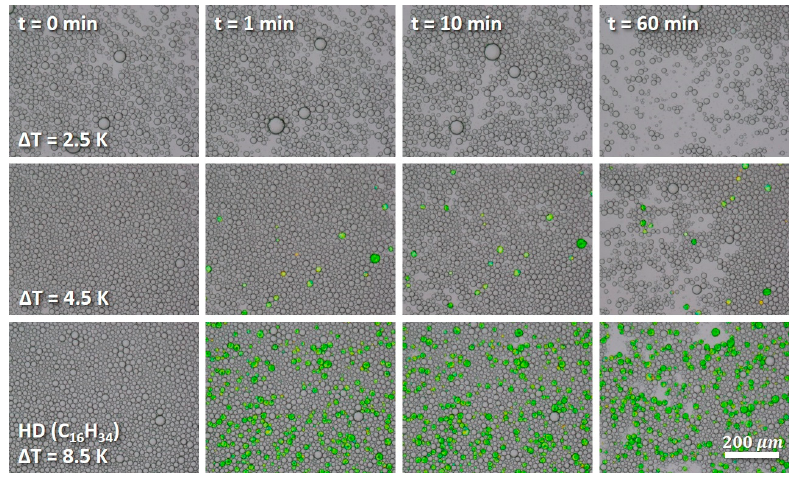
Figure A4. Micrographs of 1 wt % HD dispersions at different supercooling during one-hour isothermal observations. Length of the scale bar is 200 µm.